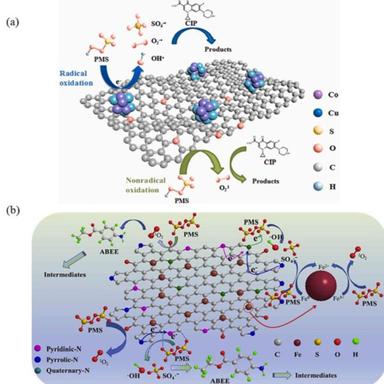
The combination and transformation of radical and non-radical pathways. (a) The reaction mechanism for CIP removal by Cu@Co-MOF-71 derived CuCo/C activated PMS . Copyright 2022 Elsevier. (b) The reaction mechanism for ABEE removal by NH2-MIL-53(Fe)-derived NMC-50 activated PMS . Copyright 2019 Elsevier.